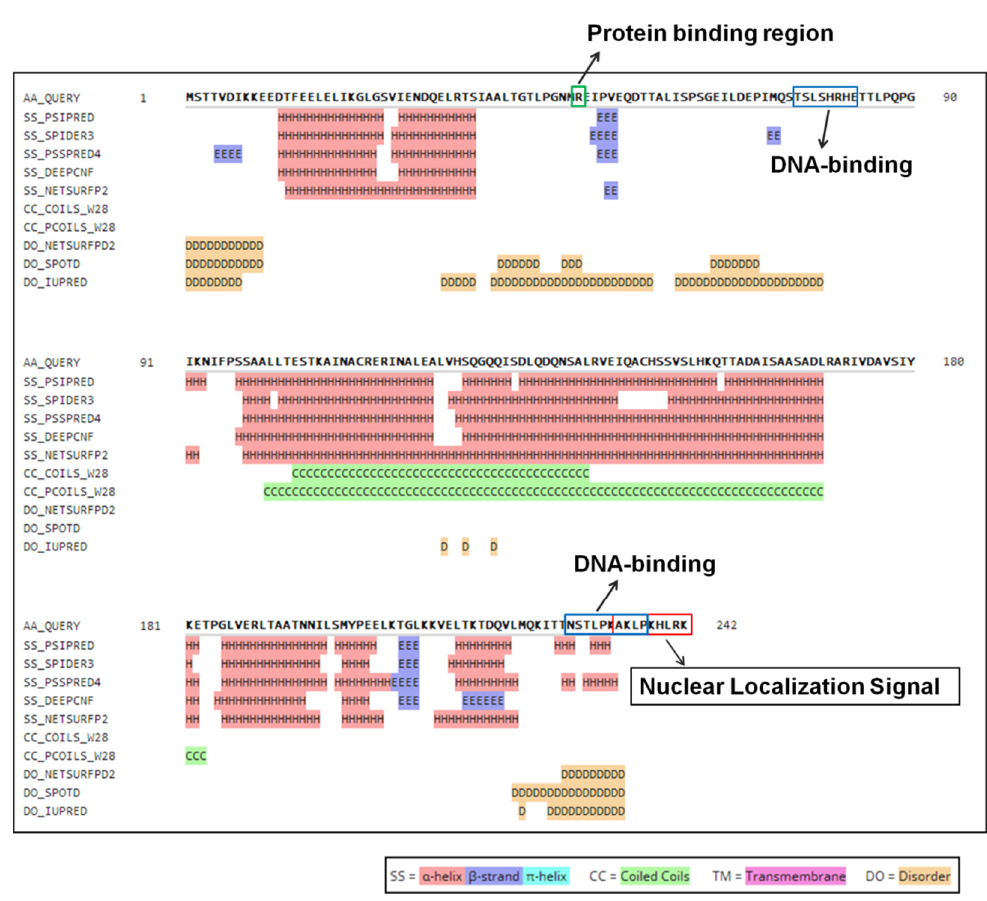
Figure 1. Predicted secondary structure and binding site of protein ORF I. The green box indicates protein binding region. The blue box indicates DNA-binding sites. The red box indicates a nuclear localization signal.